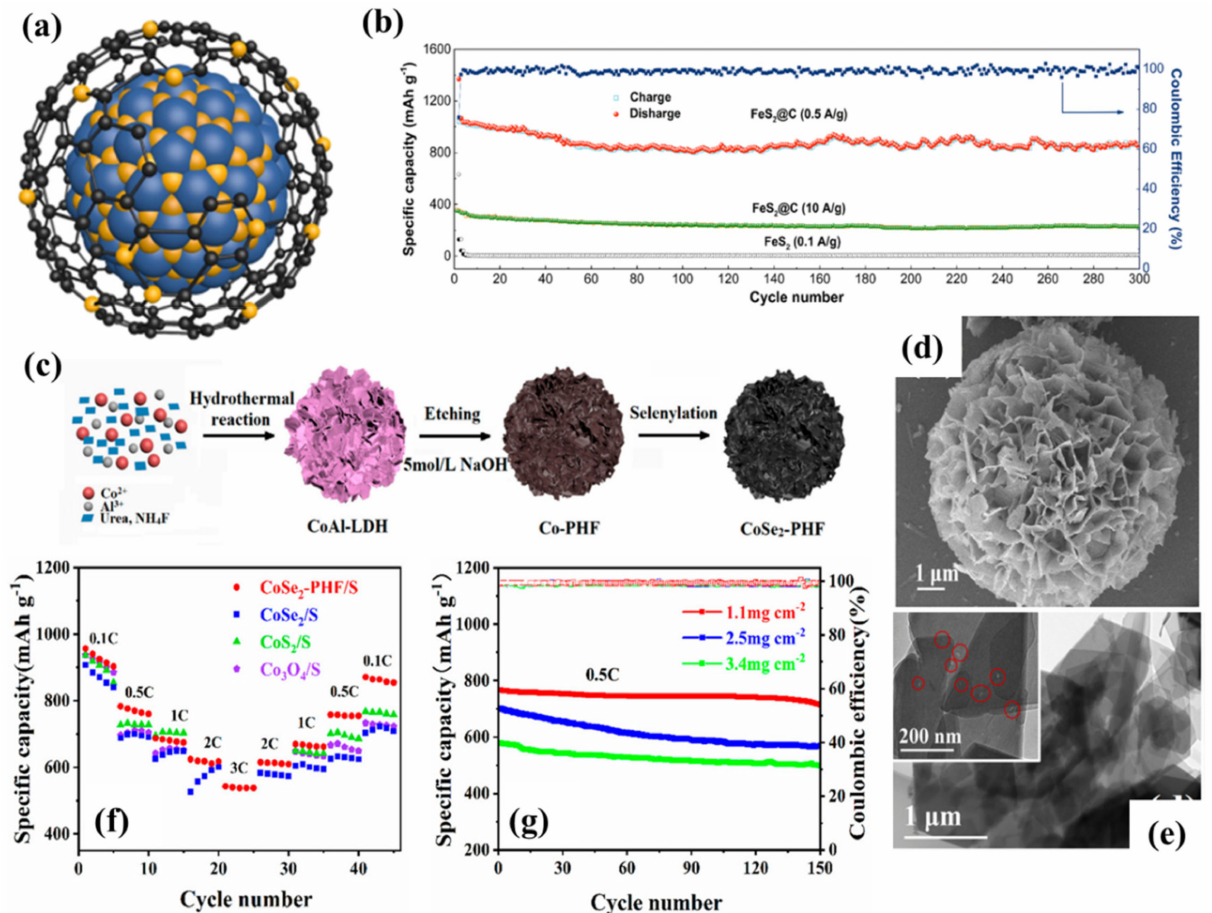
Figure 13. ( a ) A single FeS 2 @C nanoparticle is depicted; [Fe] atoms are represented by light-blue balls, [S] atoms are represented by light-yellow balls, and [C] atoms are represented by black balls. ( b ) Cycling performance of FeS 2 @C and FeS 2 electrodes at various current densities between 0.01 and 3.00 V. Adapted with permission [300]. Copyright (2020) American Chemical Society. ( c ) A diagram of the CoSe 2 -PHF production process. ( d ) CoSe 2 -PHF SEM and ( e ) CoSe 2 -PHF TEM. ( f ) At various current rates, the rate performance of CoSe 2 -PHF/S, CoSe 2 /S, CoS 2 /S, and Co 3 O 4 /S